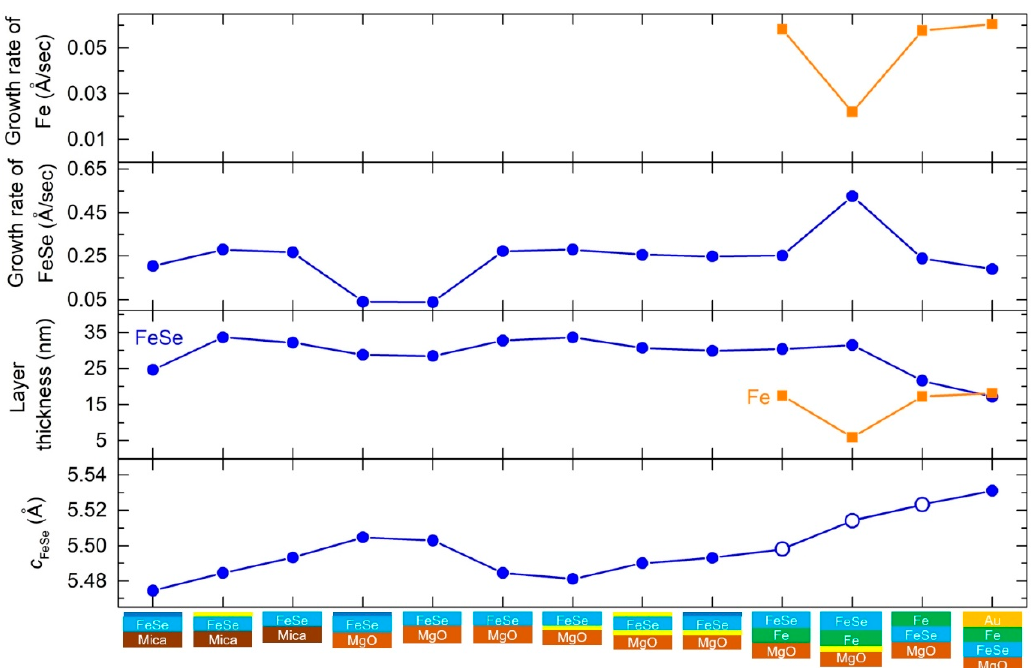
Figure 2. Comparison of c -axis of FeSe, c FeSe , layer thickness, and growth rate of FeSe and Fe among FeSe/mica, FeSe/MgO, FeSe/Fe/MgO, Fe/FeSe/MgO, and Au/Fe/FeSe/MgO films. The schematic images illustrated at the vertical axis represent the films of various preparation conditions. Yellow lines at the FeSe/MgO, Fe/MgO, and FeSe/mica interfaces show the MgO and mica substrates pre-annealed in Se vapor. Dark blue and yellow lines at the film surface depict the films post-annealed in UHV and Se vapor, respectively. Open blue circles in the c FeSe window represent the FeSe thin films that show resistive signatures of superconductivity. Please note that most of the films were grown at a similar growth rate of 0.25 Ås -1 except the three examples as indicated. Note that the error in the c -axis lattice parameter evaluated from reproducibility tests would be ±0.004 Å for FeSe/Fe/MgO and ±0.007 Å for FeSe/MgO.